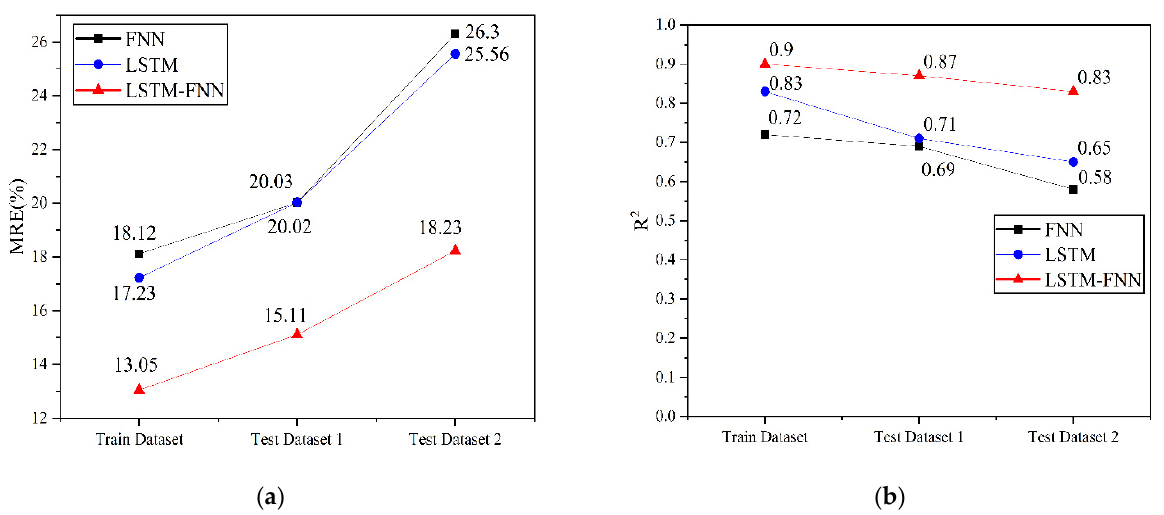
Figure 9. Comparison chart of ROP prediction results: ( a )the MRE of three ROP prediction models; ( b ) the 𝑅 (cid:2870) of three ROP prediction models